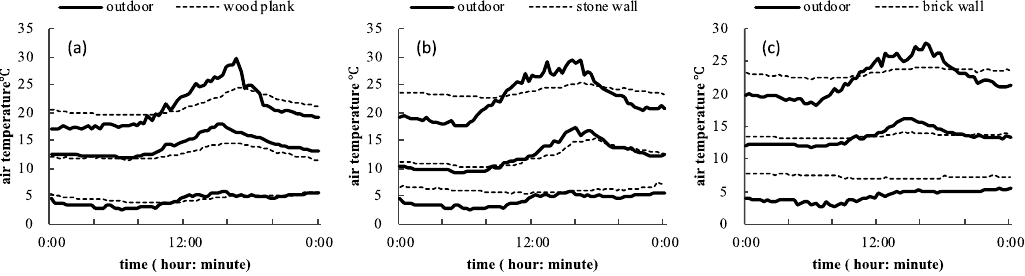
Figure 16. Quartile graphs of indoor air temperature from: ( a ) 22–28 August 2011 (summer); ( b ) 12–20 April 2012 (transition season); and ( c ) 23 January to 18 February 2013 (long-term winter period).